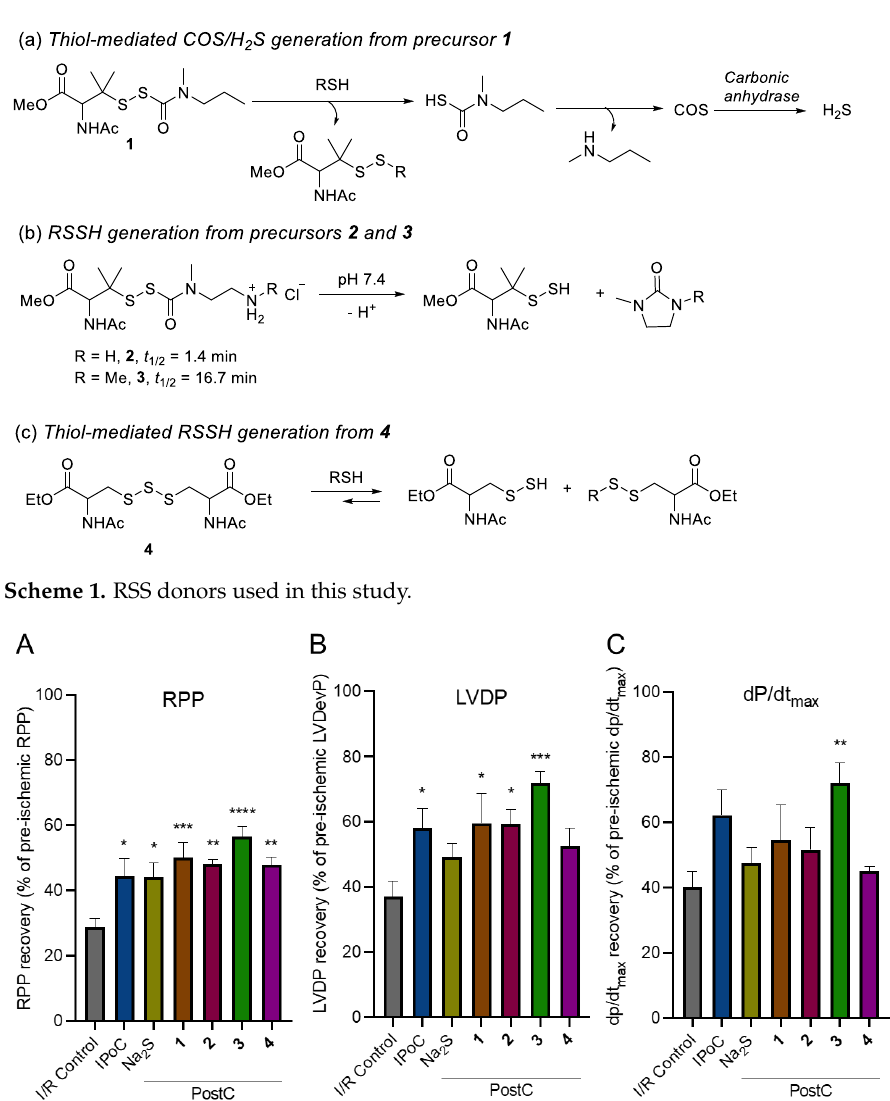
Figure 2. Cardioprotective effects induced by mechanical or pharmacological post-conditioning with different RSS at 100 µ M. ( A ) Post-ischemic left ventricular RPP functional recovery; ( B ) Post-ischemic left ventricular developed pressure recovery; ( C ) Post-ischemic left ventricular rate of contraction. Results are expressed as the mean ± SEM using values obtained at 90 min of reperfusion normalized to the respective pre-ischemic value (n = 8 in each group) * p , 0.05, ** p , 0.005, *** p , 0.001, **** p < 0.0001 vs. I/R-Control. Table 2. Isolated heart parameters observed at the end of reperfusion in the different treatment groups. Group